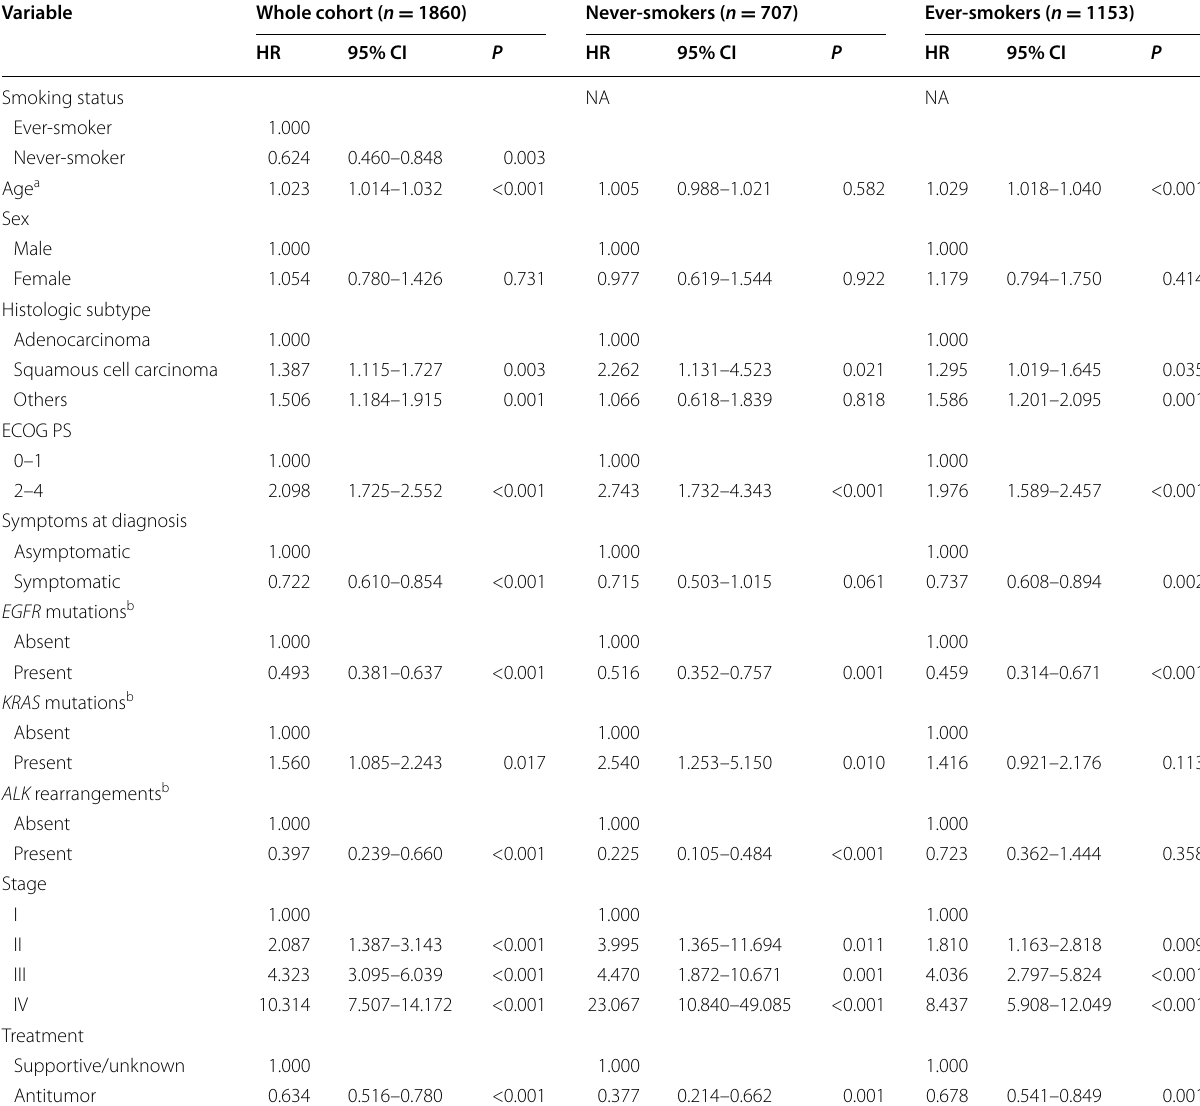
Table 3 Multivariate analysis of overall survival using the Cox regression in 1860 patients with